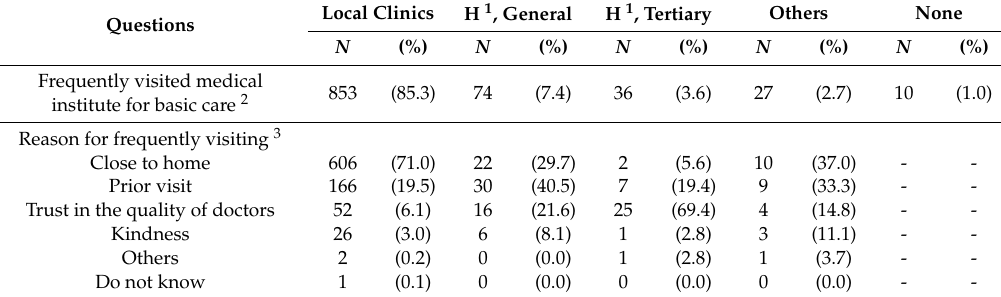
Table 4. Frequently visited medical institute and the reason for visiting.